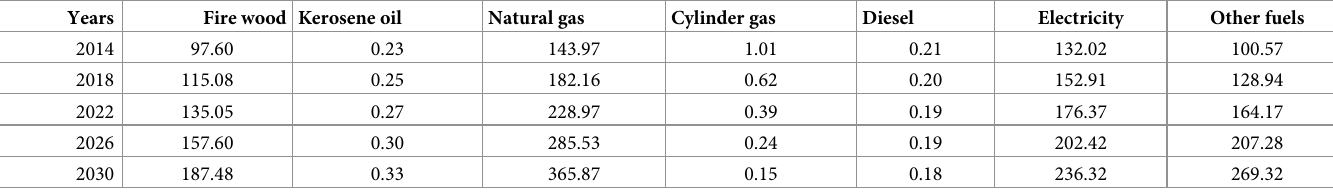
Table 15. Per capita energy demand